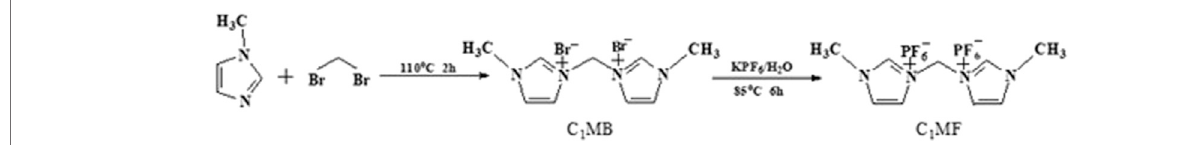
FIGURE 1 | Schematic diagram of the synthesis of C 1 MF.